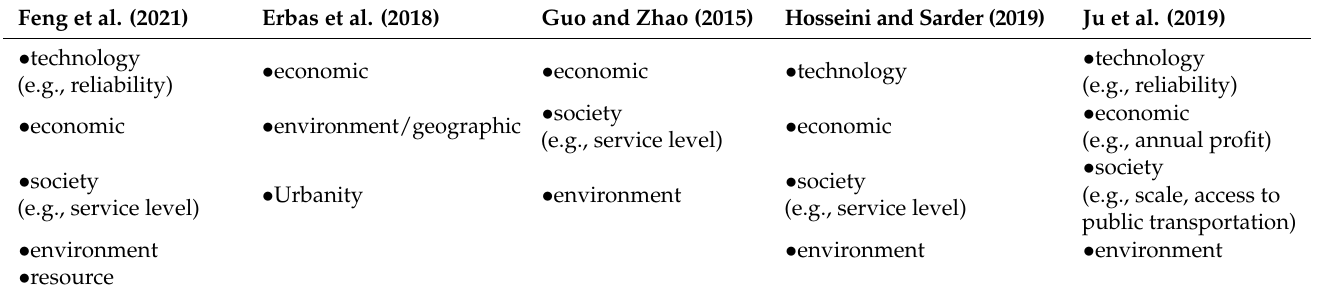
Table 1. Components of the site selection system of charging